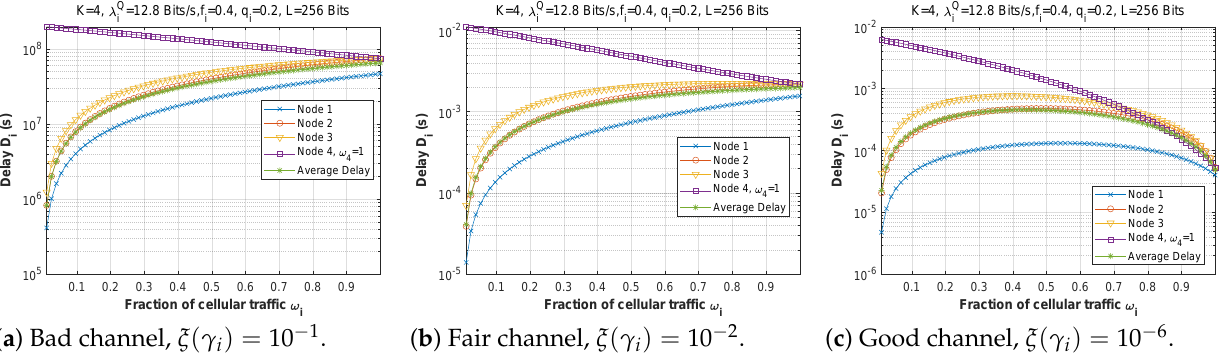
Figure 16. Setting 1: The delay experienced at each mobile device when varying the fraction of cellular traffic with the bit error rate ξ ( γ i ) .